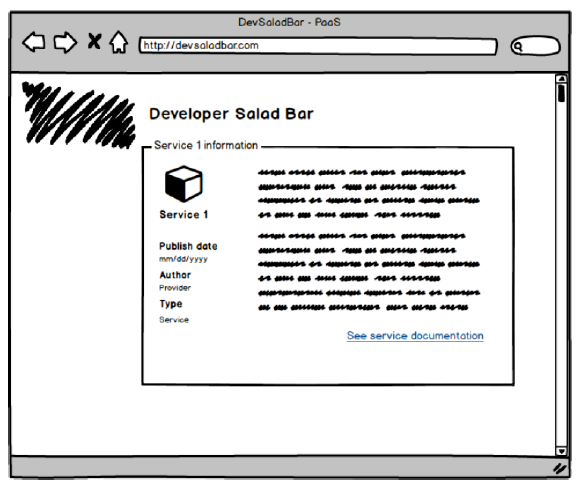
Fig. 6. . Service description page in DSB.